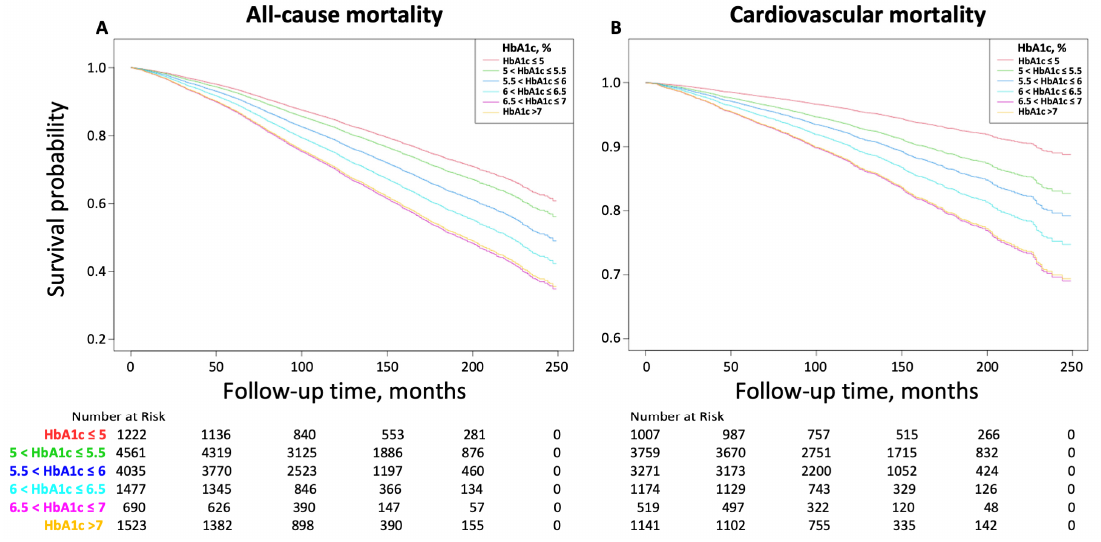
As shown in Figure 2, Kaplan–Meier survival curves diverge according to HbA1c level. More risk for both all-cause and cardiovascular mortality was observed when HbA1c ≤ 5% or HbA1c > 7% compared to other groups.